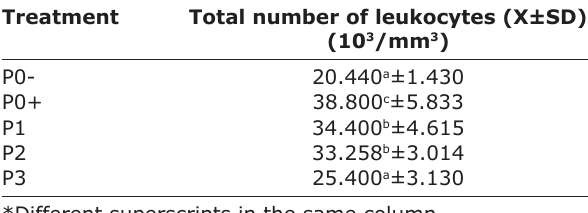
Table-1: The total number of leukocytes in the broiler chickens infected with M. gallisepticum bacteria after the